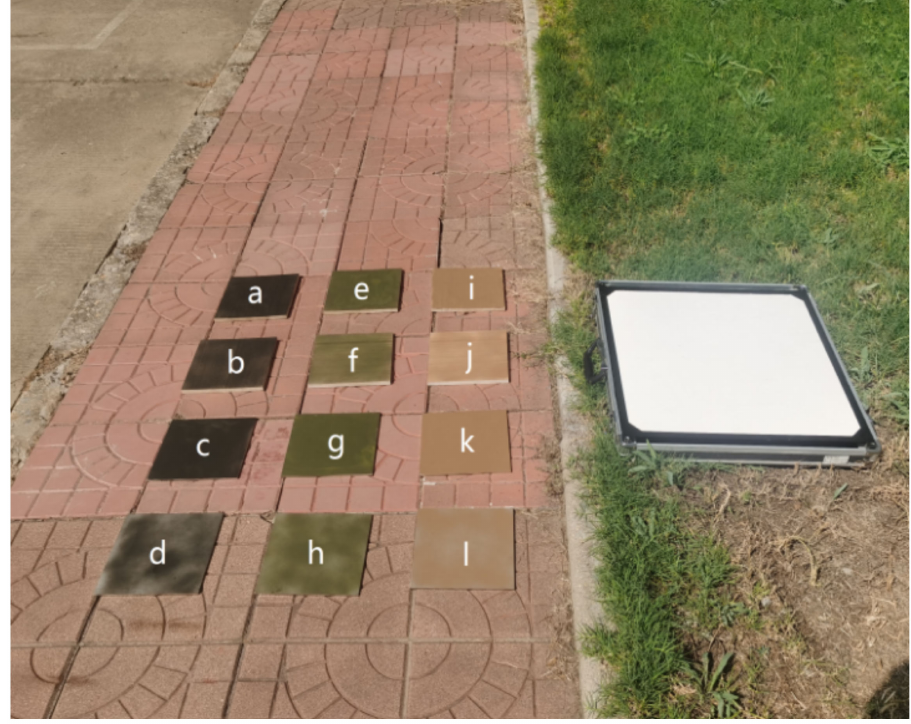
Figure 7. Relative position of the target in Experiment